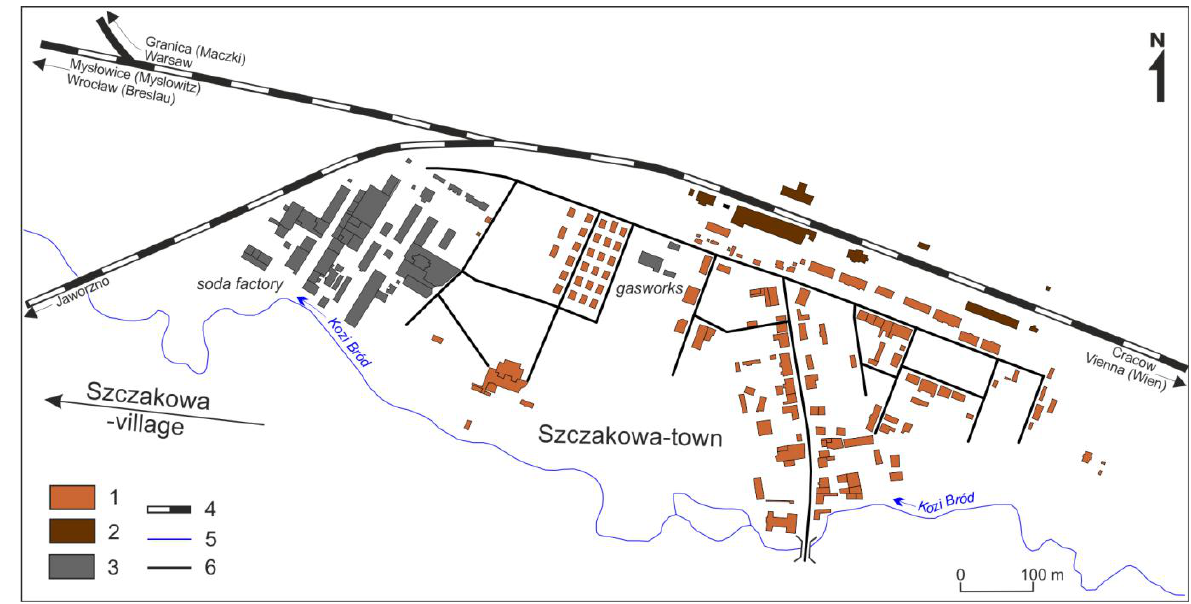
Fig. 4. Spatial arrangement of Szczakowa in the late nineteenth century 1 – dwelling houses and public buildings; 2 – railway buildings; 3 – industrial buildings; 4 – railway line; 5 – stream; 6 –